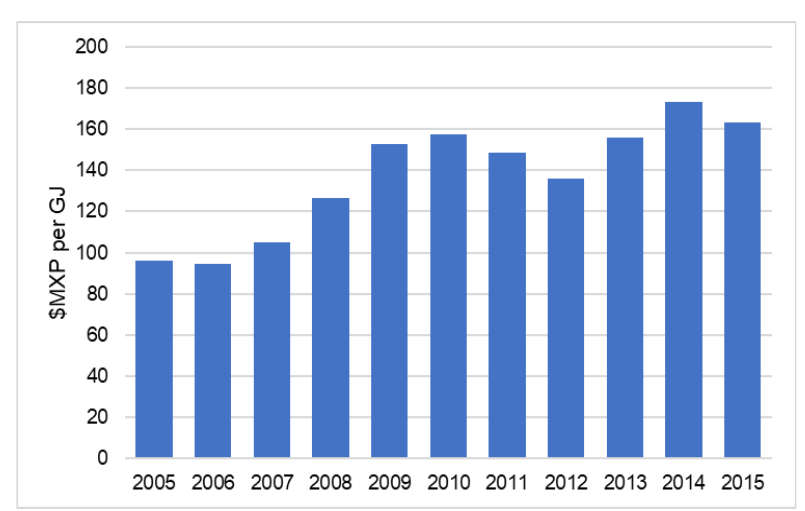
Fig. 3. Natural gas price in 2015 $MXP, 2005–2015 (SENER, 2016).